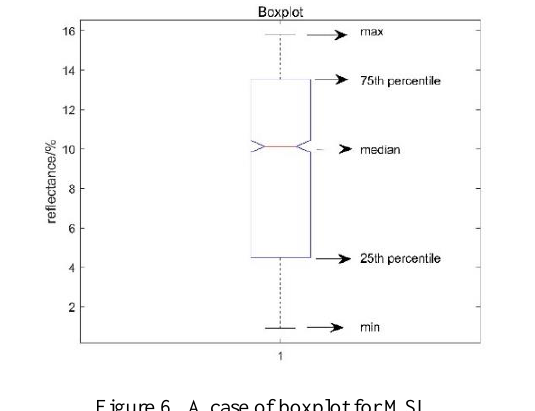
Figure 6. A case of boxplot for